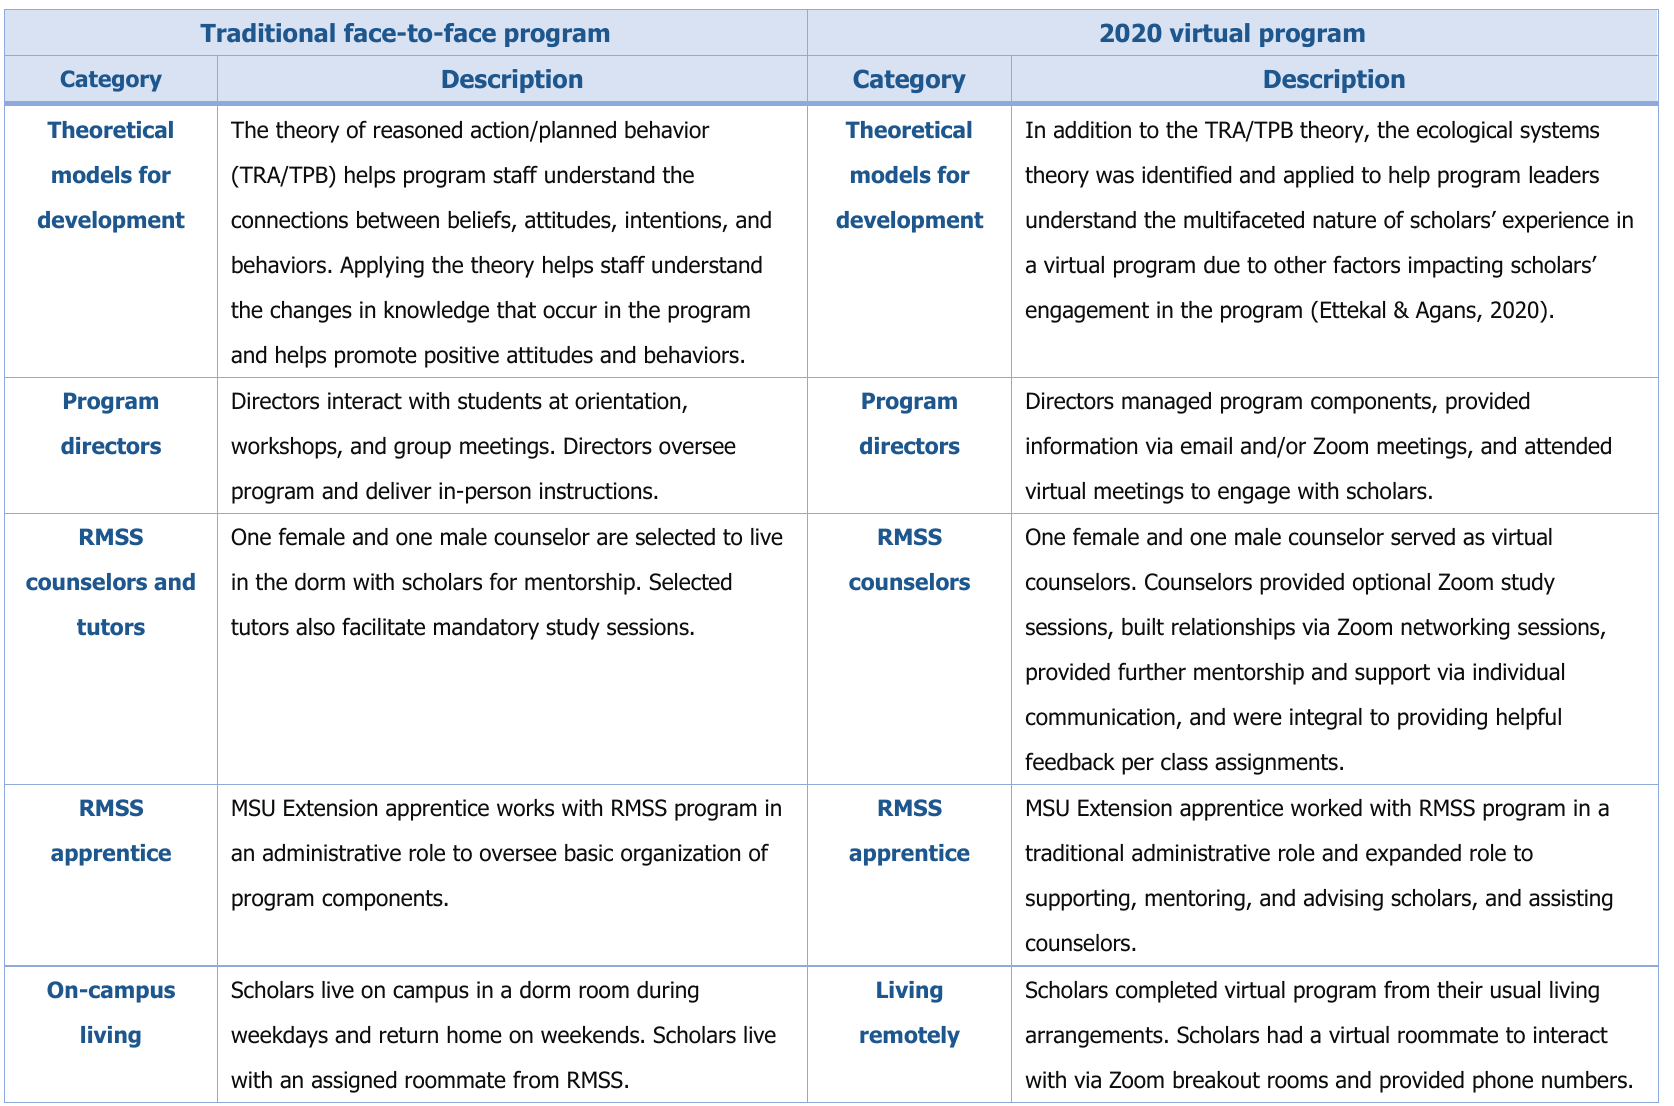
Table 1. Comparison of Delivery